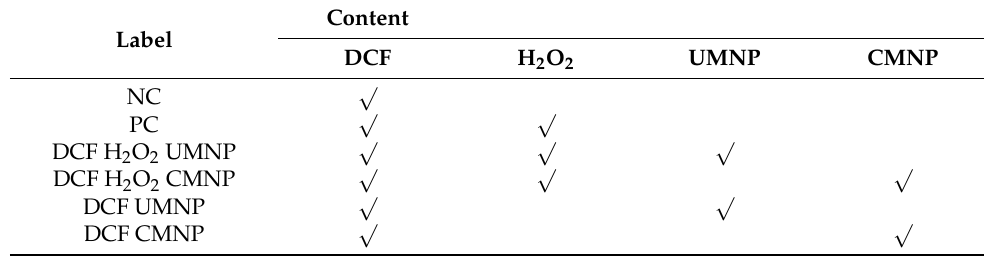
Table 2. Composition of the six labeled samples prepared to analyze the intracellular